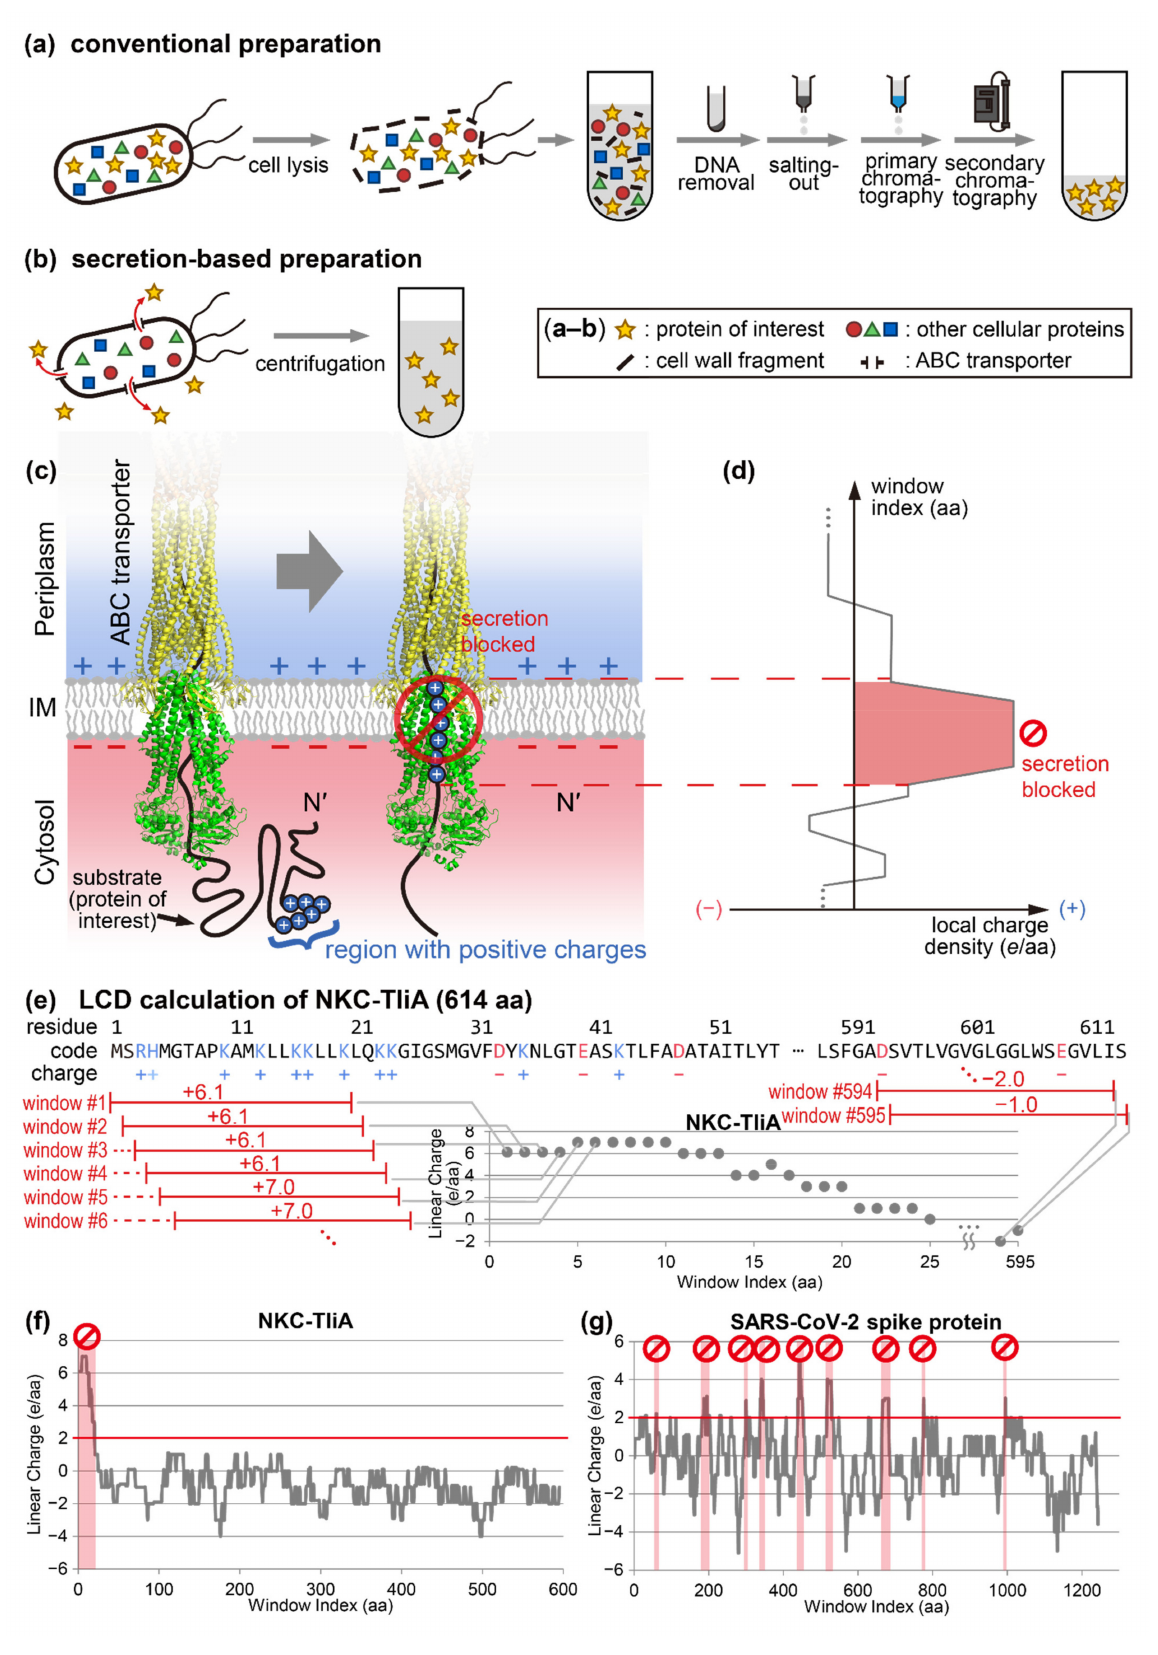
Figure 1. Schematics of this study. ( a ) A summary of conventional protein preparation methods, which involve lysis of the expression host followed by multiple purification steps. ( b ) A summary